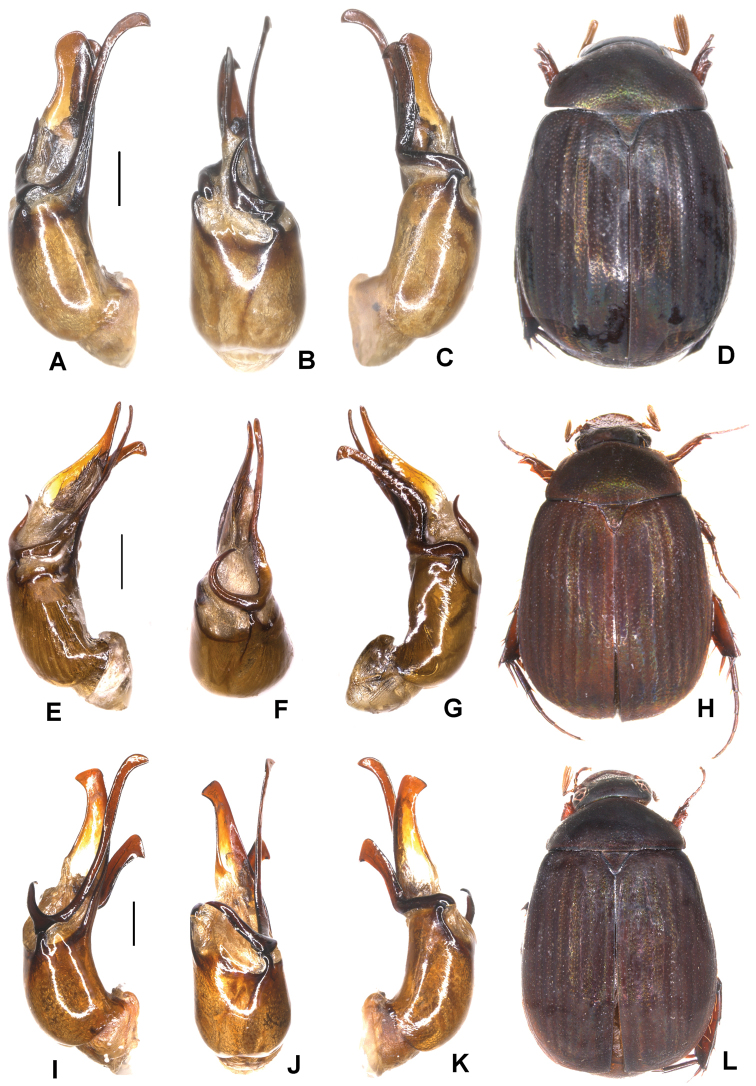
A–DTetrasericasubrotundata sp. n. (holotype) E–HT.matsumotoi Kobayashi, 2017 (Thailand: Chom Thong) I–LT.kiriromensis sp. n. (holotype) A, E, I aedeagus, left side lateral view C, G, K aedeagus, right side lateral view B, F, J parameres, dorsal view D, H, L habitus. Scale bars: 0.5 mm. Habitus not to scale.